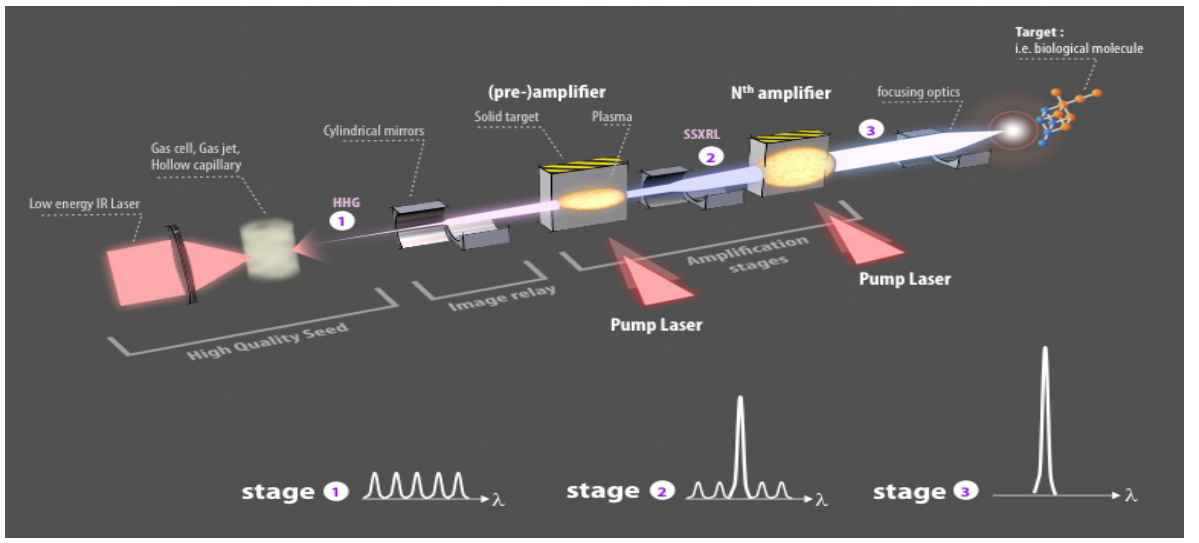
Figure 4. Artistic view of an amplification chain starting, from left to right, with the HHG source, focusing optics, pre and main amplifiers.